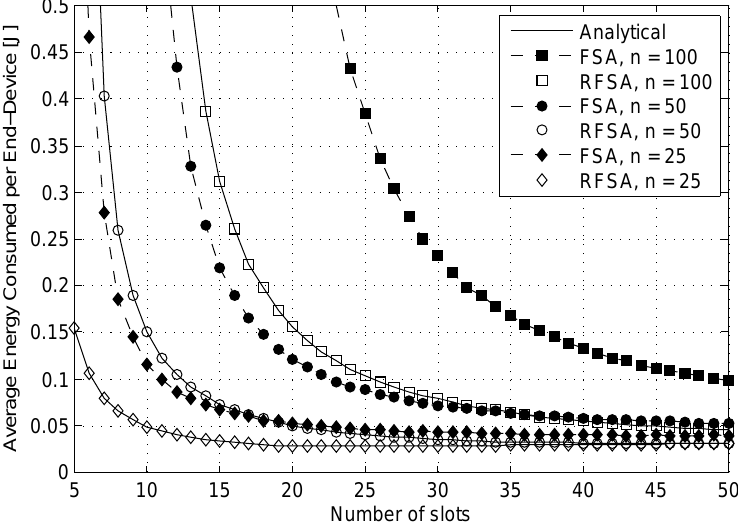
Figure 5. Average energy consumed per end-device in a data collection round over the frame